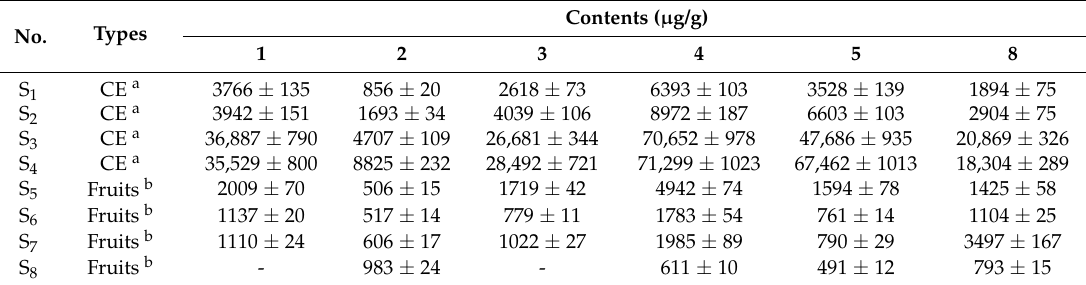
Table 2. Contents of compounds 1 – 8 in different F. suspensa extracts and F. suspensa fruits